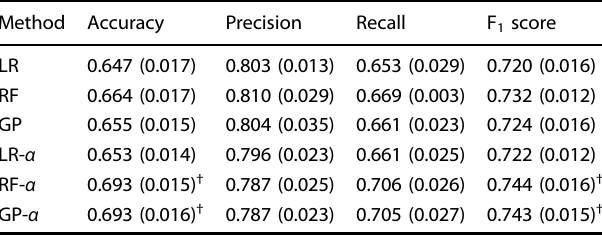
Categories include student attributes (see Supplementary Table